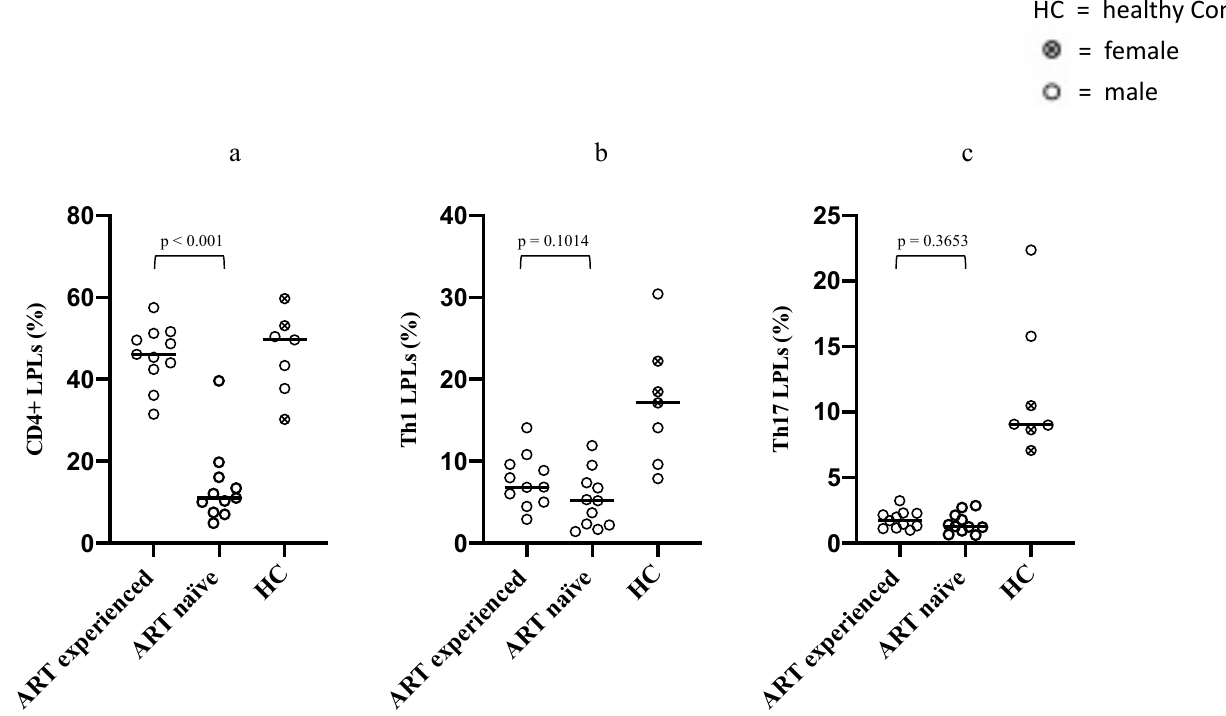
Figure 1. This figure shows comparison for overall CD4 + LPLs ( a ), IFN- γ expressing (Th1) CD4 + LPLs ( b ) and IL-17 expressing (Th17) CD4 + LPLs ( c ) detected within mucosal biopsies between ART-naïve PLWH and long-term ART-treated PLWH. Each dot represents a patient biopsy, while the horizontal line represents the median. The healthy control group’s results are shown on the right of each panel. p -values were determined by Mann–Whitney U test.